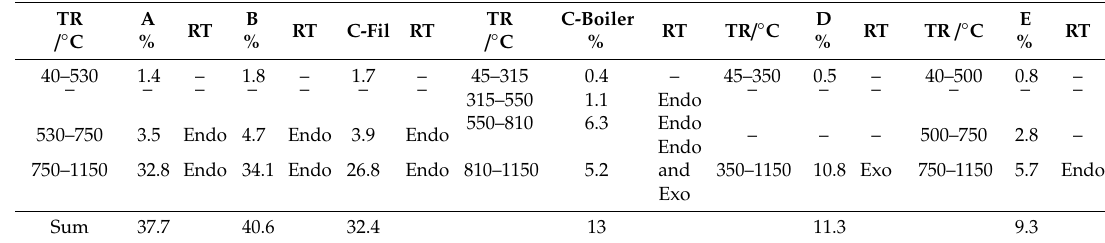
Table 6. Temperature range and percent mass loss for each fly ash and reaction type; temperature range (TR), reaction type (RT), endothermic reaction (Endo), and exothermic reaction